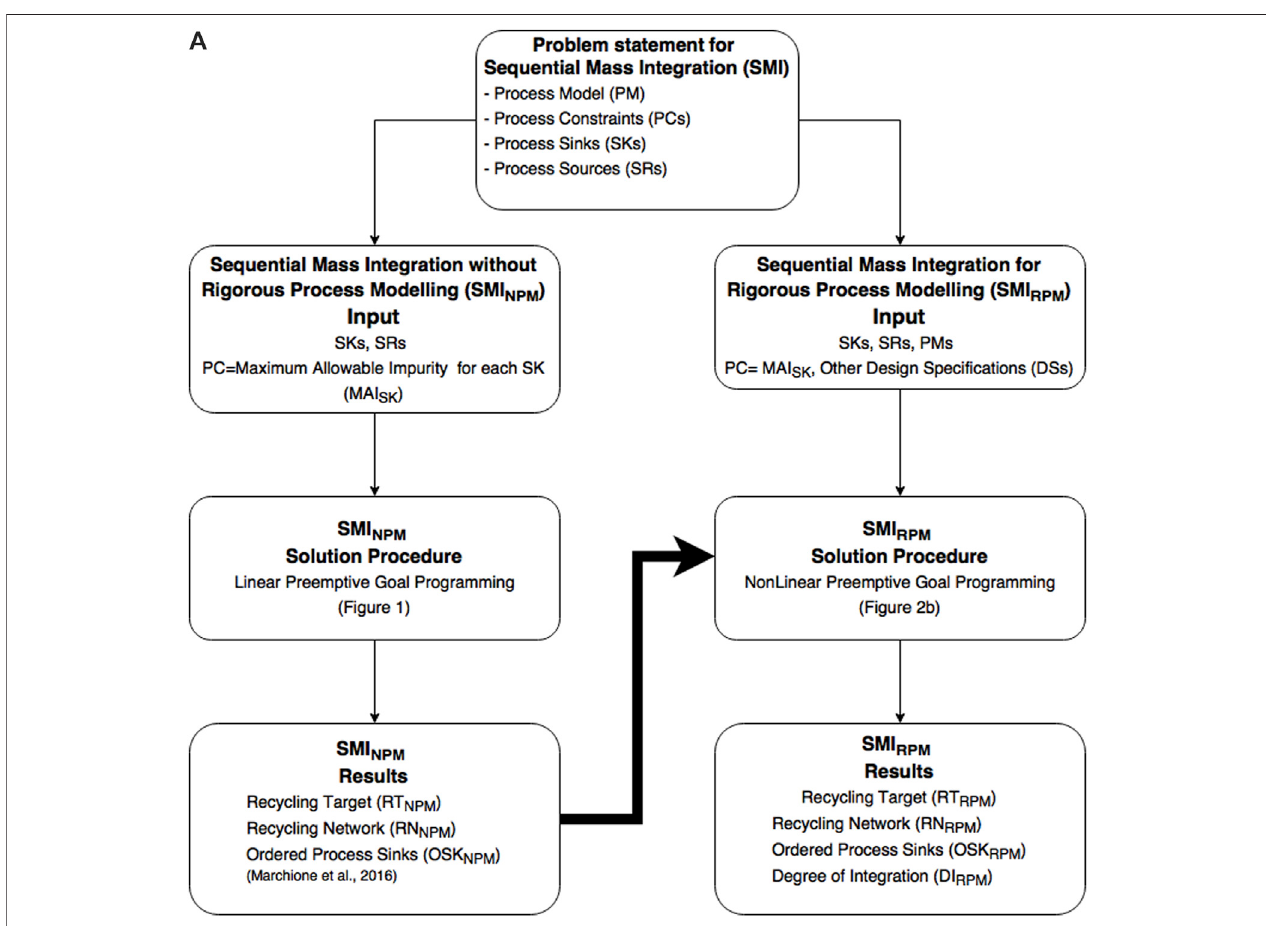
FIGURE 2 | Flowchart describing the sequential mass integration approach with rigorous process modelling (SMI RPM ): (A) Overview of the sequential mass integration procedures and interaction between SMI NPM and SMI RPM , (B) SMI RPM solution procedure.